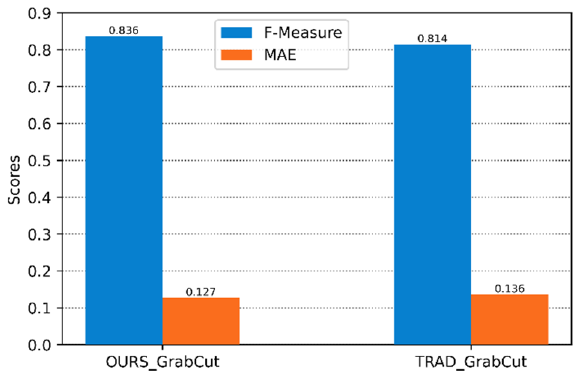
Figure 10. F ‐ Measure and MAE obtained by our method and traditional